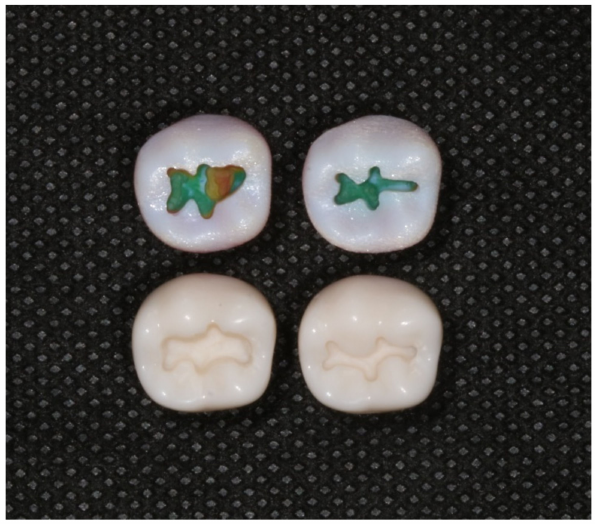
Figure 1. Upper row: Class I preparations in 3D-printed teeth with multicolored layers. Lower row: Class I preparation in conventional plastic teeth. Left column: preparations that are too wide and deep. Right column: ideal